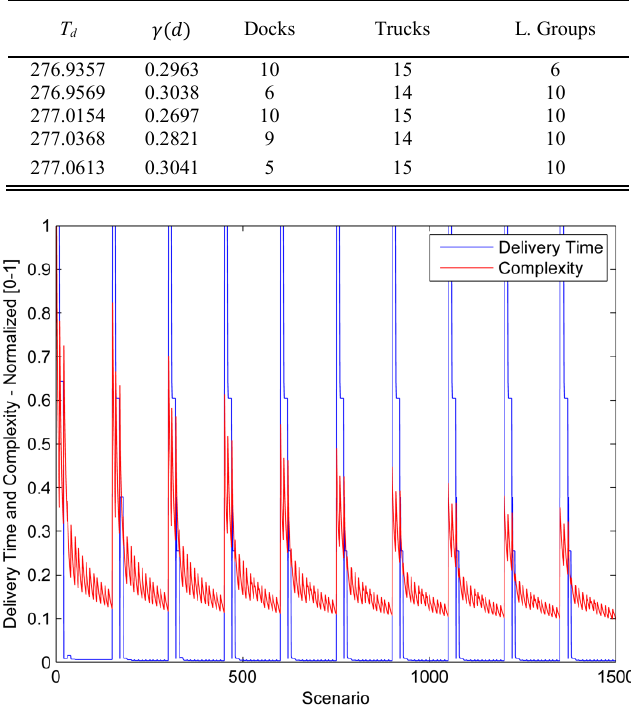
Fig. 3. Relationship between delivery time and